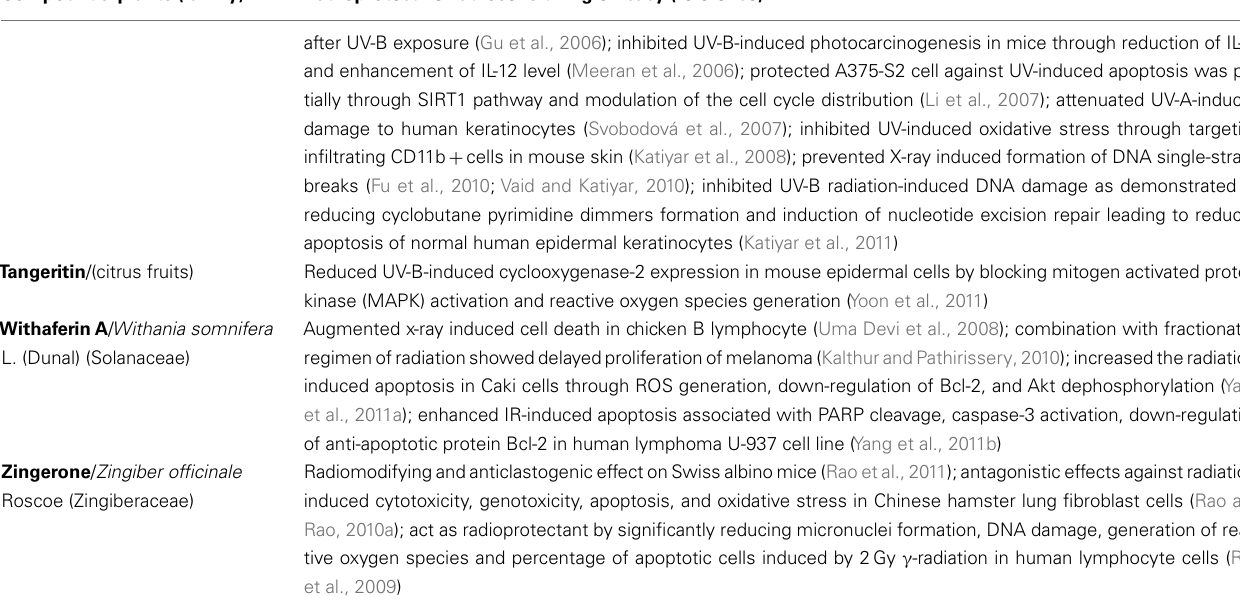
Compounds/plants (family) Radioprotective/radiosensitizing efficacy